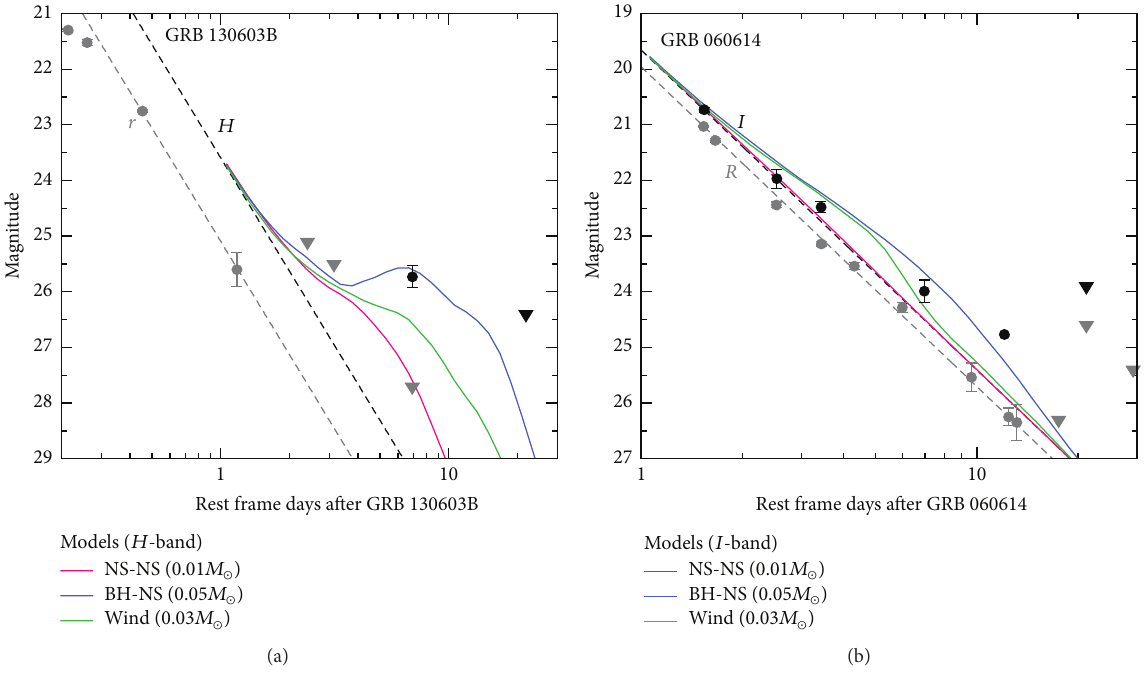
Figure 4: Comparison of kilonova models with GRB 130603B (a) and GRB 060614 (b). The models used in these plots are those with relatively high ejecta masses: APR4-1215 (NS-NS, 𝑀 ej = 0.01𝑀 ⊙ [48]), H4Q3a75 (BH-NS, 𝑀 ej = 0.05𝑀 ⊙ [59]), and a wind model with 𝑀 ej = 0.03𝑀 ⊙ (this paper). The H4Q3a75 model is a merger of a 1.35 𝑀 ⊙ NS and a 4.05 𝑀 ⊙ BH with a spin parameter of 𝑎 = 0.75 . This model adopts a “stiff” EOS H4 [65, 66] which gives a 13.6km radius for 1.35 𝑀 ⊙ NS. For GRB 130603B, the afterglow component is assumed to be 𝑓 ] ∝ 𝑡 −2.7 [67, 68]. For GRB 060614, it is assumed to be 𝑓 ] ∝ 𝑡 −2.3 [69], which is a conservative choice (see [70] for a possibility of a steeper decline). The observed and model magnitudes for GRB 060614 are given in the Vega system as in the literature